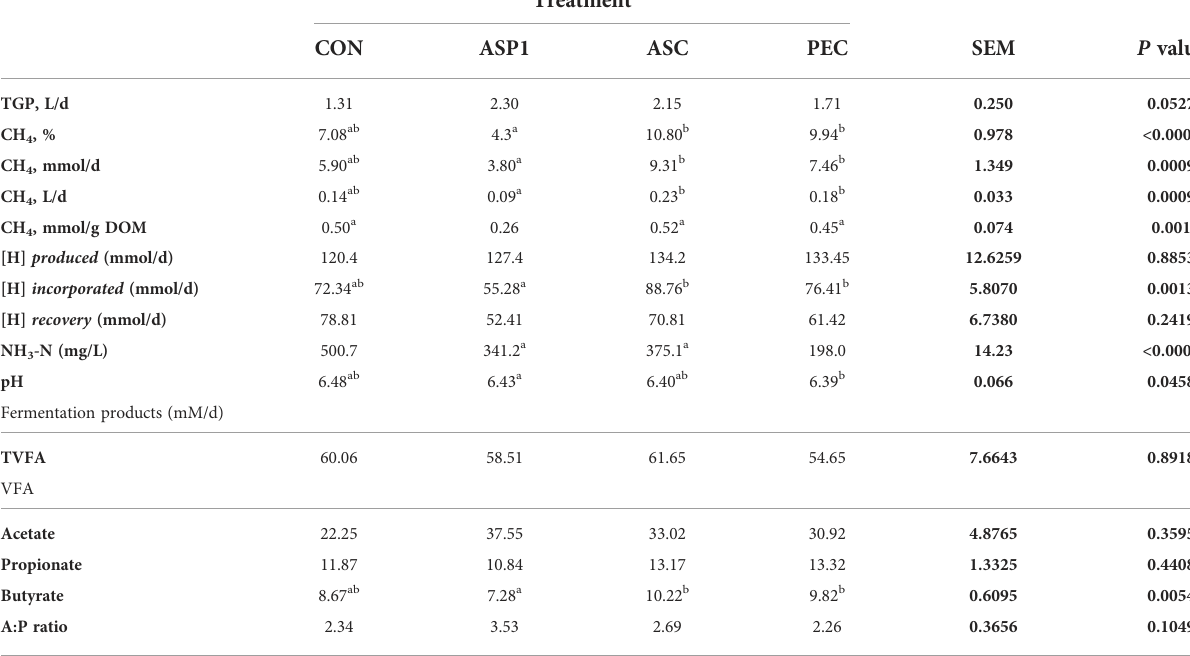
TABLE 5 Effects of seaweed inclusion on gas production parameters and fermentation patterns in the RUSITEC system (Experiment 1).